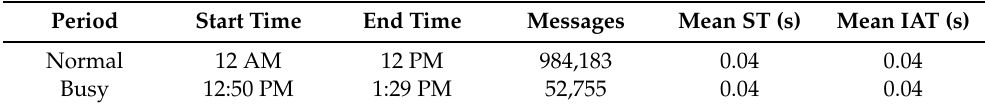
Table 2. Translation data different time